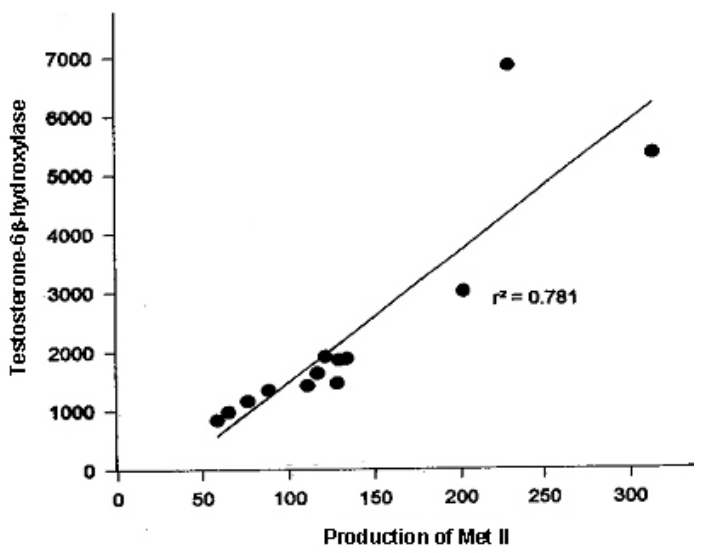
FIGURE 2. Correlation between testosterone-6 β -hydroxylase activity and the biosynthesis of metabolite 2 of a tested NCE in different human liver microsomes. Unpublished results from P. Kremers, ATC LiŁge,